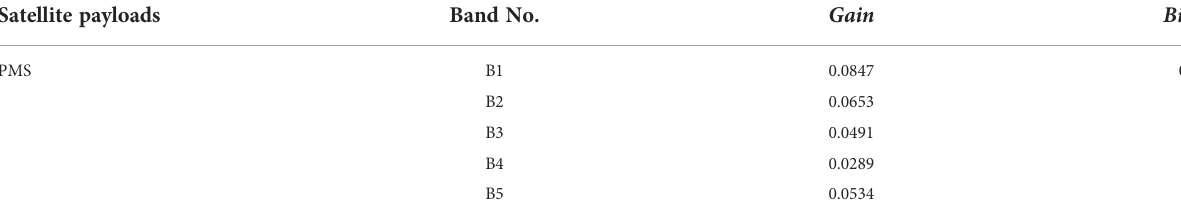
TABLE 4 GF-6 PMS calibration parameters in 2019. Satellite payloads Band